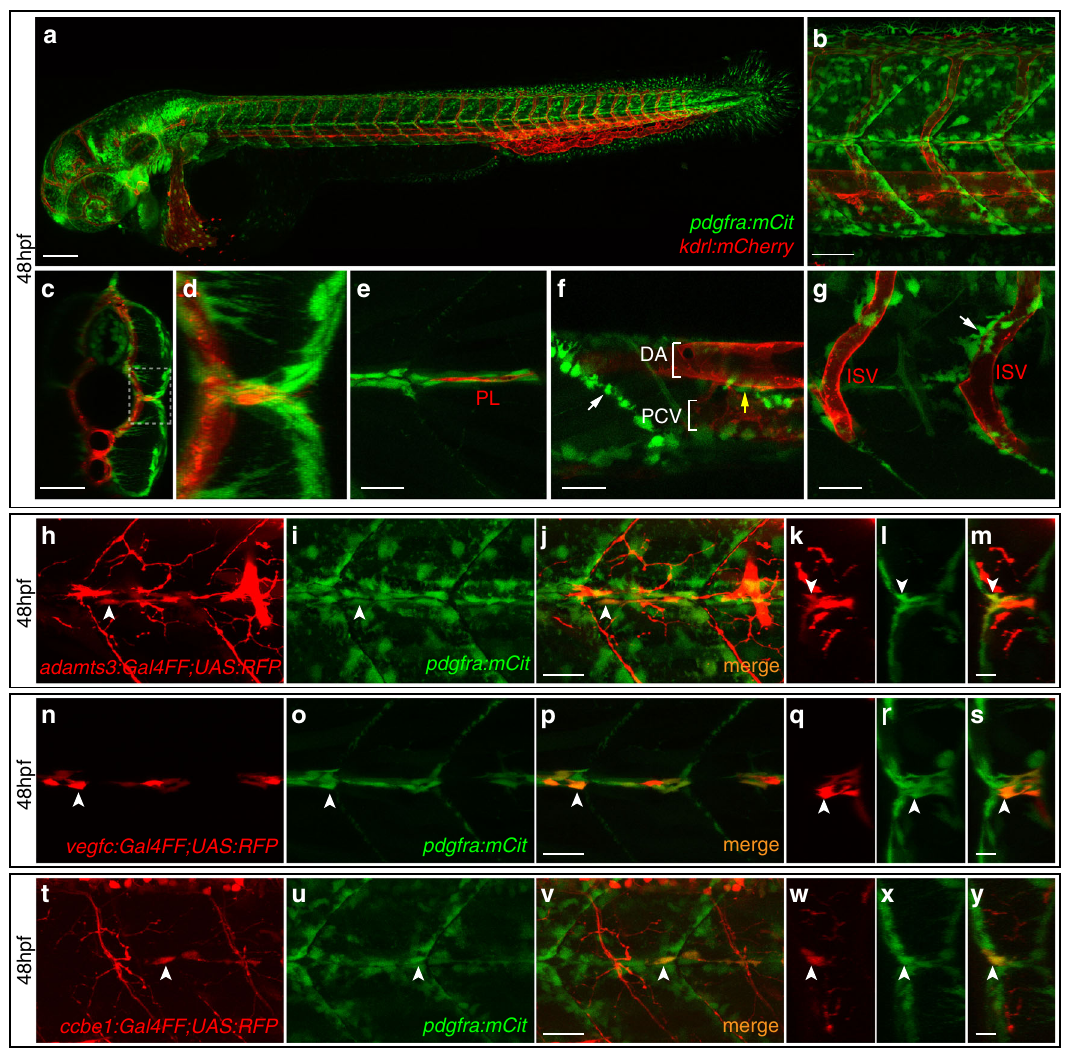
Fig. 8 Co-expression of adamts3 , ccbe1 , and vegfc with pdgfra at the horizontal myoseptum. a – g Confocal images of pdgfra:mCitrine; kdrl:mCherry double transgenic embryos at 48 hpf. a Lateral view giving an overview of the pdgfra -expression domains. b Higher magni fi cation of the trunk region above the yolk extension. c , d Virtual cross section of the trunk shown in b . d Zoom-in of the boxed area in ( c ) showing the HM region in detail. e – g Partial projections of ( b ). e At the HM, pdgfra -expressing cells (in green) are surrounding the PL cells (in red). f pdgfra is expressed by cells located along the segment boundaries (white arrow) as well as by individual cells located around the main axial blood vessels (yellow arrow). g At the level of the ISVs, individual pdgfra + cells locate in close proximity to the blood vessels. h – j , n – p , and t – v Lateral views and k – m , q – s , and w – y virtual cross sections of the HM region in double transgenic embryos at 48 hpf. White arrows highlight cells with co-expression. h – m A subpopulation of pdgfra -expressing cells (green) is co-labeled by the adamts3 reporter transgene (red) at the HM. n – s Cells at the HM co-express vegfc (red) and pdgfra (green). t – y All ccbe1 -expressing cells at the HM (red) show co-expression of pdgfra (green). Scale bar in a : 100 µ m; b , c : 50 µ m; e – j , n – p , t – v : 25 µ m; k – m , q – s , w – y : 10 µ m. DA dorsal aorta, HM horizontal myoseptum, hpf hours post fertilization, ISV intersegmental vessel, PCV posterior cardinal vein, PL parachordal